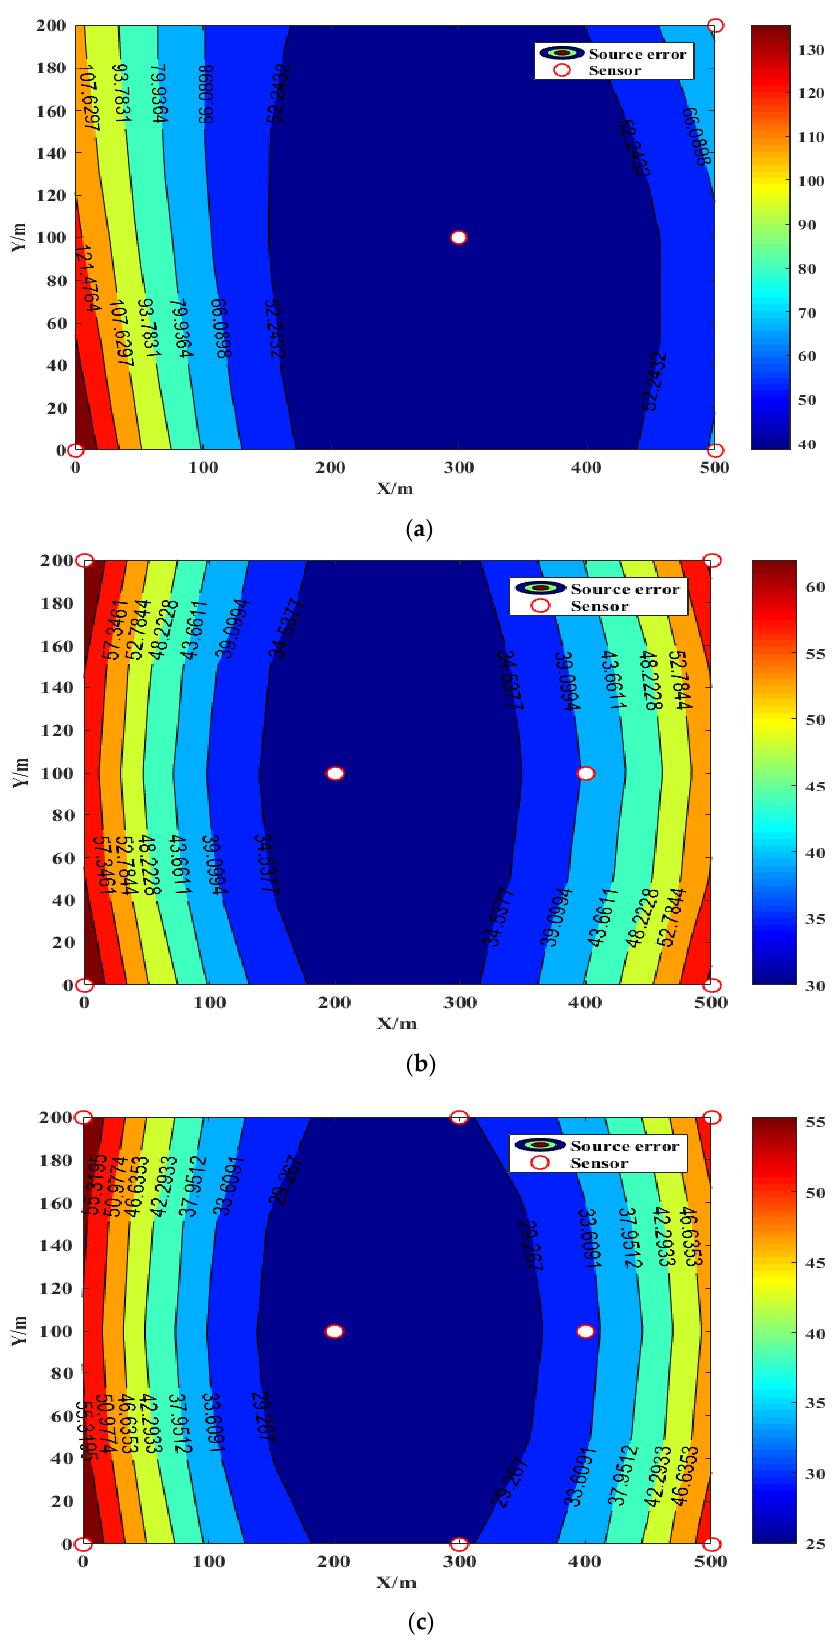
Figure 6. Error evaluation of different network layout schemes. ( a ) Positioning error of Scheme I. ( b ) Positioning error of Scheme II. ( c ) Positioning error of Scheme III.